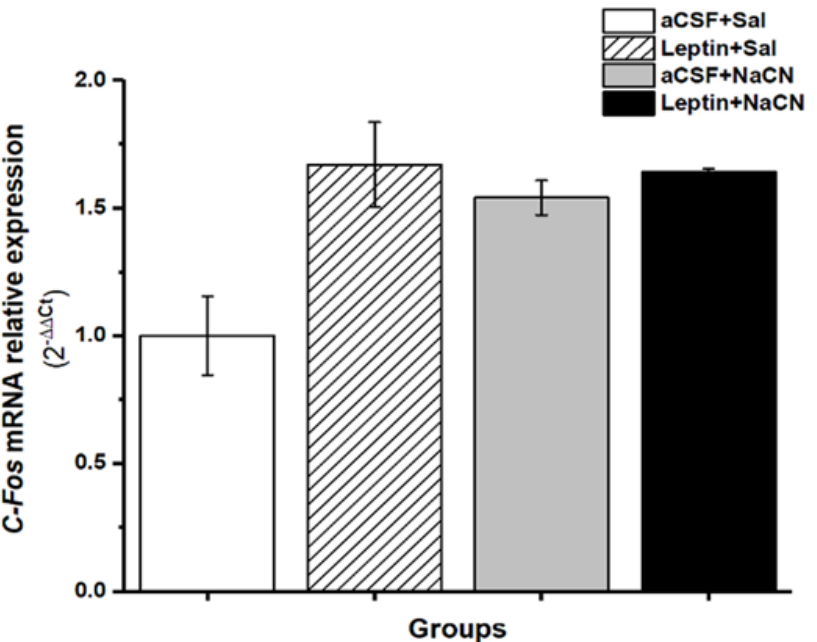
Figure 5. Relative expression of c-Fos mRNA receptors in healthy rats with leptin or aCSF injections in the cNTS before NaCN or saline the isolated carotid sinus (ICS). The values are the mean ± SDM. To calculate the umbral cycle (Ct) the software ∆∆ C T. method was used. ANOVA with Scheffé post hoc test. aCSF, artificial cerebrospinal fluid; cNTS, commissural nucleus tractus solitarius; NaCN, sodium cyanide; Sal, saline.